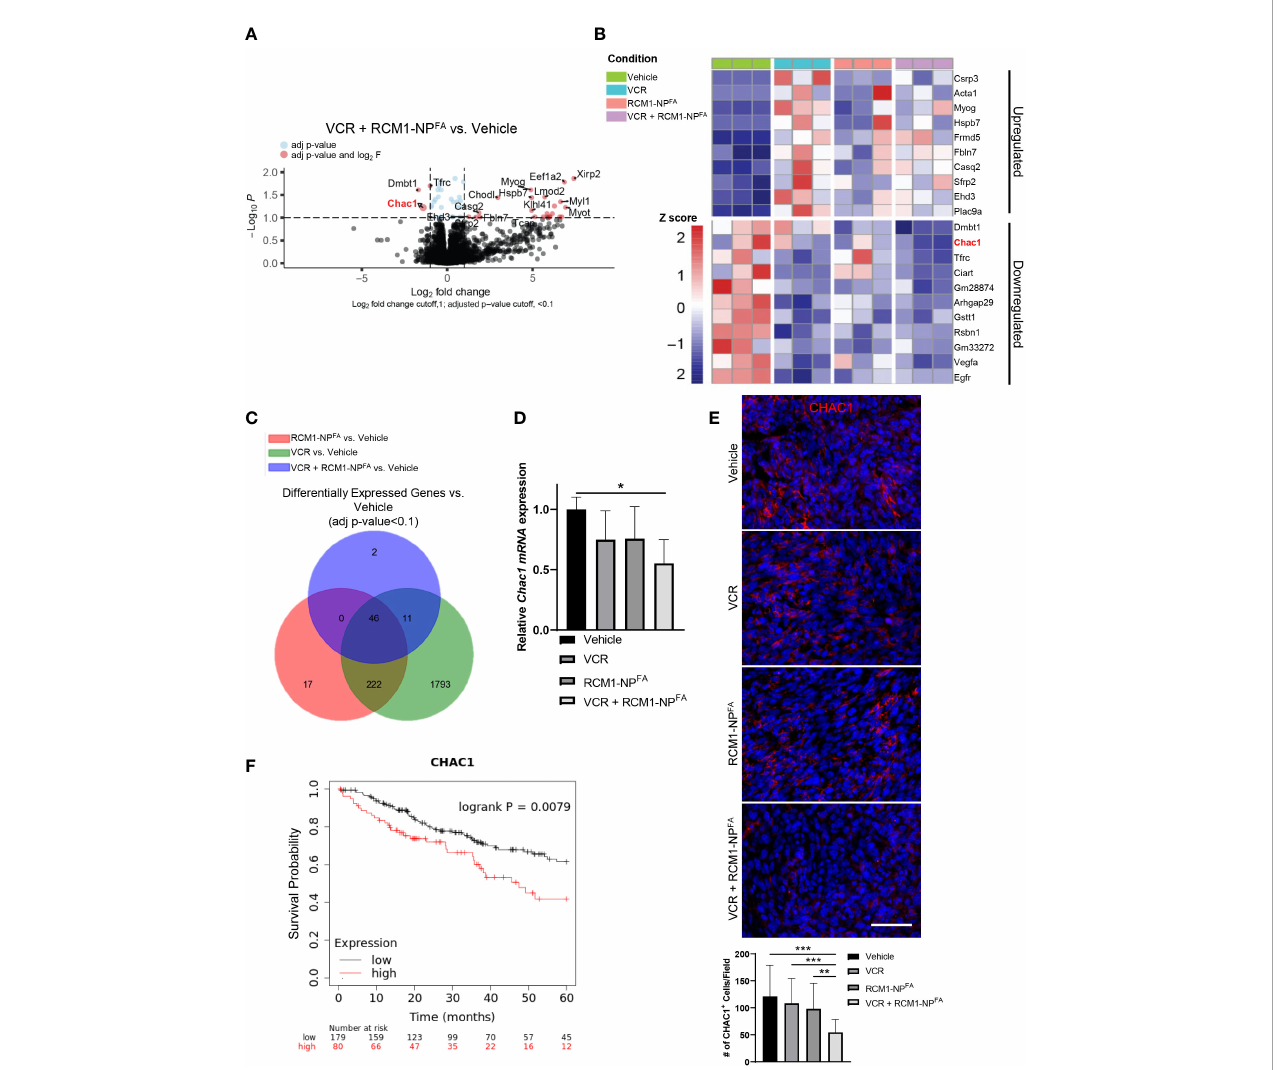
FIGURE 5 Treatment of mice with combination of low doses VCR and RCM1-NP FA results in unique gene signatures. (A) , Volcano plot shows the differential gene expression between combo-treated (VCR + RCM1-NP FA ) versus vehicle-treated (saline + empty-NP FA ) tumors. RMS tumors were dissected from mice at day 16 after treatment with VCR, RCM1-NP FA alone or in combination. Genes in blue were statistically signi fi cant with an adjusted p-value <0.1. Genes in red were statistically signi fi cant with a log 2 fold-change higher than 1. (B) , Heat map summarizing centralized and scaled normalized counts (z-score) for the top 10 upregulated and downregulated genes in VCR + RCM1-NP FA compared to vehicle control. (C) , Venn diagram showing the number of differentially expressed genes from tumors treated with VCR, RCM1-NP FA , and VCR + RCM1-NP FA compared to vehicle control. (D) , Chac1 is downregulated in the combination treated group compared to vehicle control. Bars represent fold changes compared to vehicle control using beta-actin as an internal control. Values are shown as mean ± SD. n=3 per group. *, P <0.05. (E) , Number of CHAC1 + cells (red) is reduced in combination therapy compared to each single agent alone and vehicle control in vivo . 5 random fi elds per sample were collected to quantify the number of CHAC1 + cells. Values are shown as mean ± SD. n=5-6, ** P <0.01; *** P <0.001. (F) , Kaplan Meyer curves demonstrating that sarcomas expressing CHAC1 above the median value (high expression) had signi fi cantly worse outcomes compared to patients with sarcomas expressing CHAC1 below the median expression value (low expression),